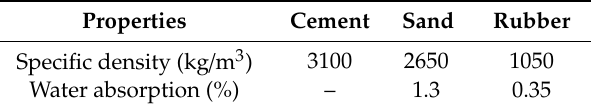
Table 1. Physical properties of used materials.